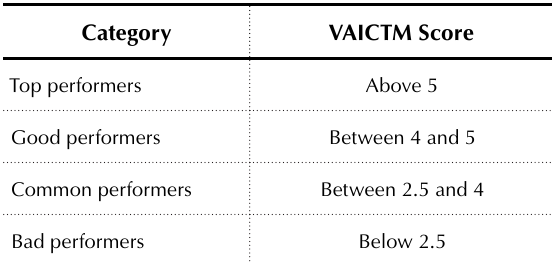
Table 1. VAIC TM scoring categorization